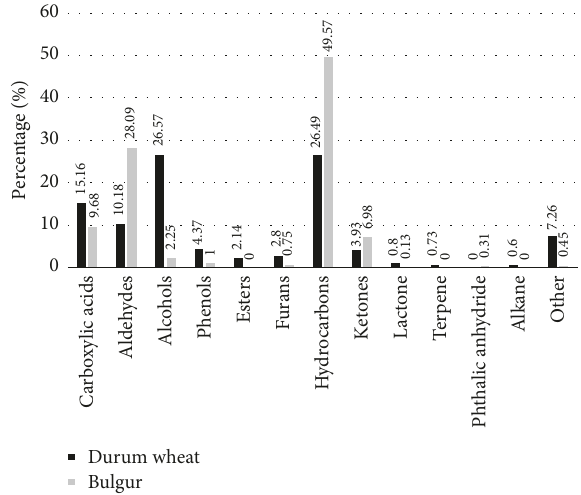
Figure 4: Change in total volatile flavor compound groups during the bulgur